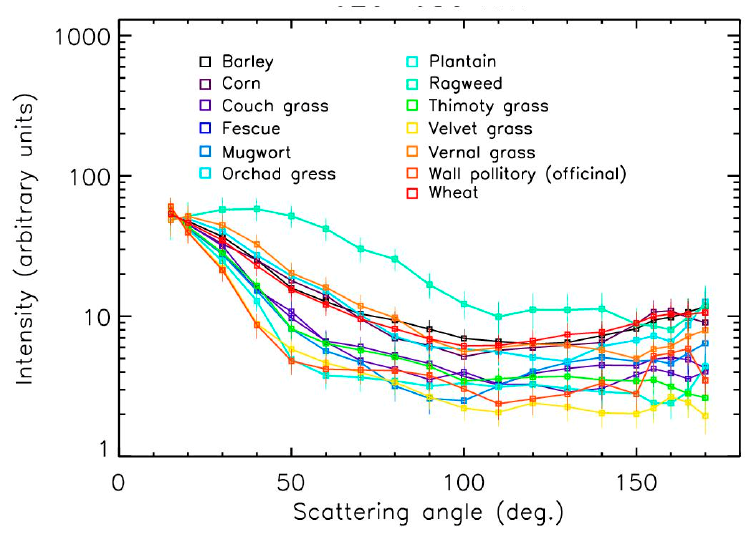
Figure 8. Intensity curves in the red domain for grass and weed pollens.